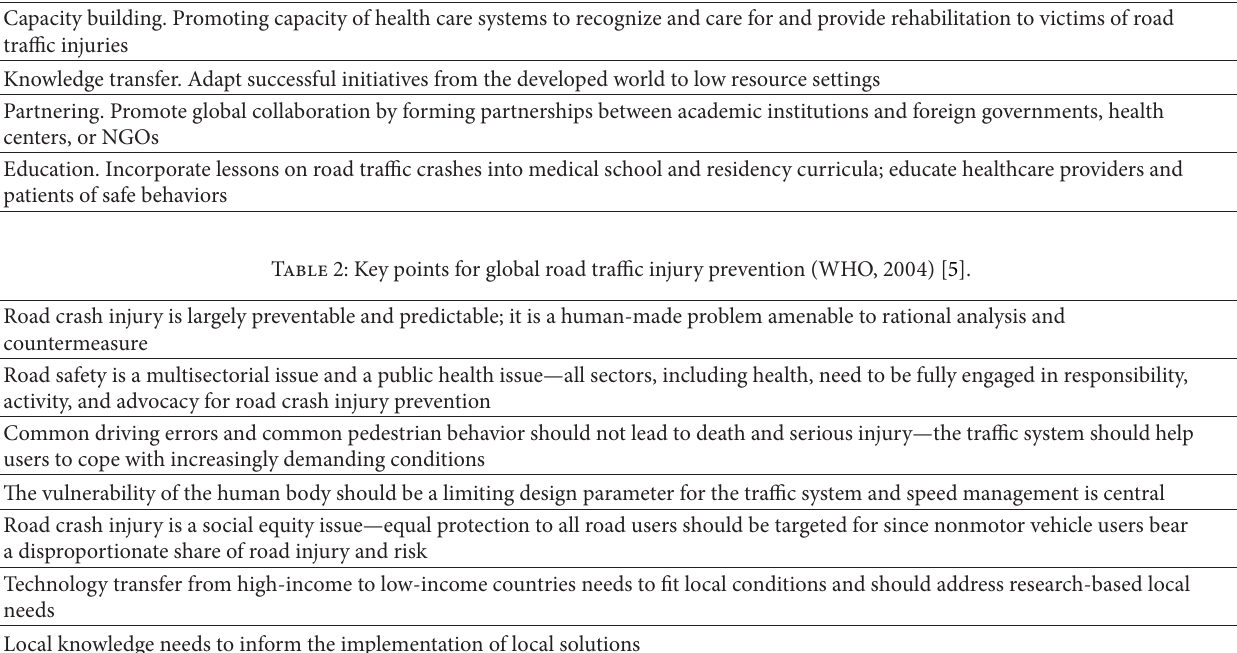
Table 1: Ways for EM practitioners to get involved in global road safety.